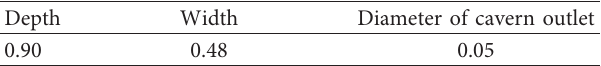
Table 6: Minimum geometric parameters of similar simulation model